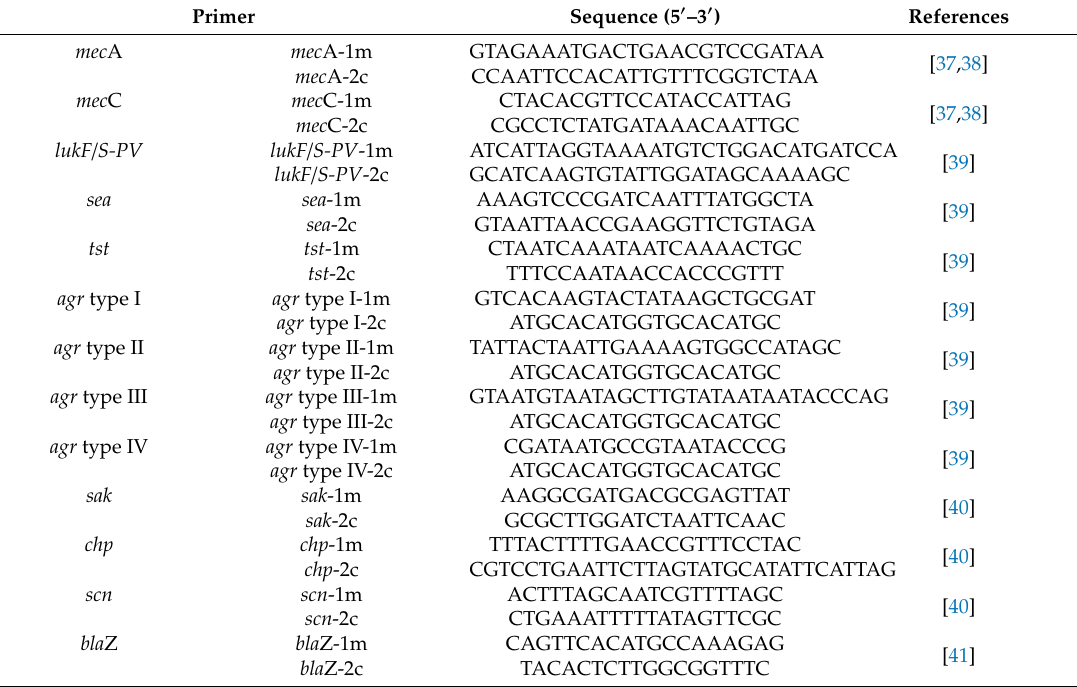
Table 1. The primer sequences used in this study.